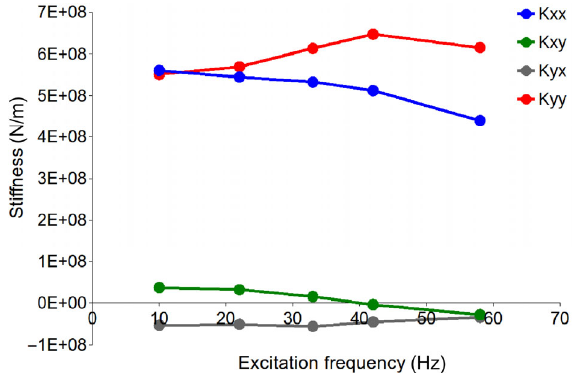
Fig. 8 Sample direct and cross stiffness coefficients as function of excitation frequency. Test with a four pad tilting pad journal